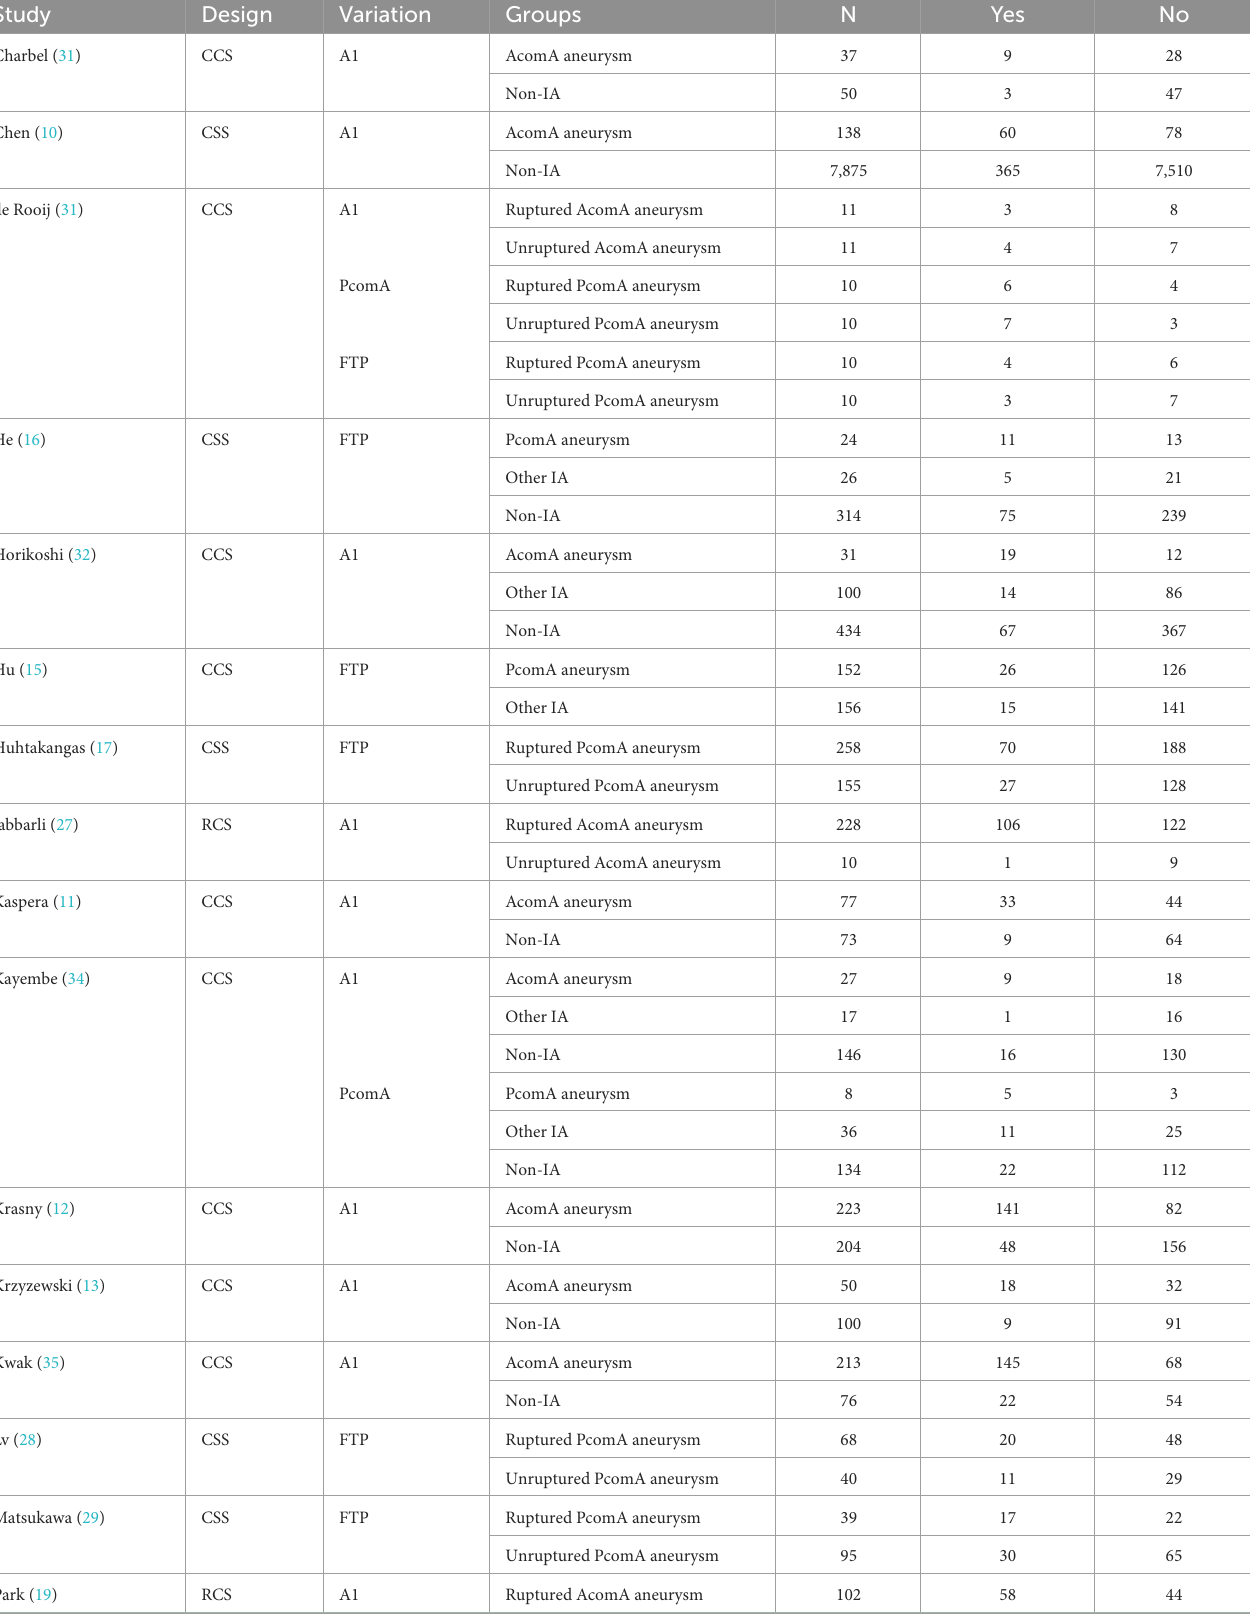
TABLE 2 Summary of the case group, control group, and COW variations of the included